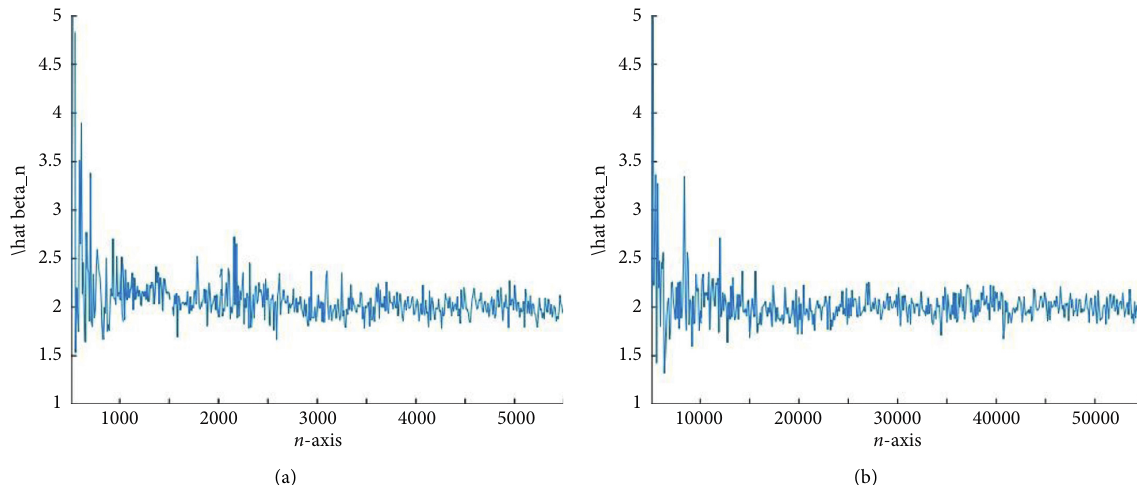
Figure 2: The simulation of the estimator 􏽢 β